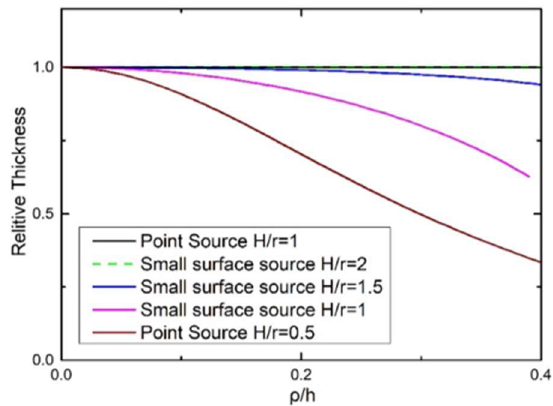
Figure 9. Distribution of the thin film thickness on the spherical surface substrate holder.